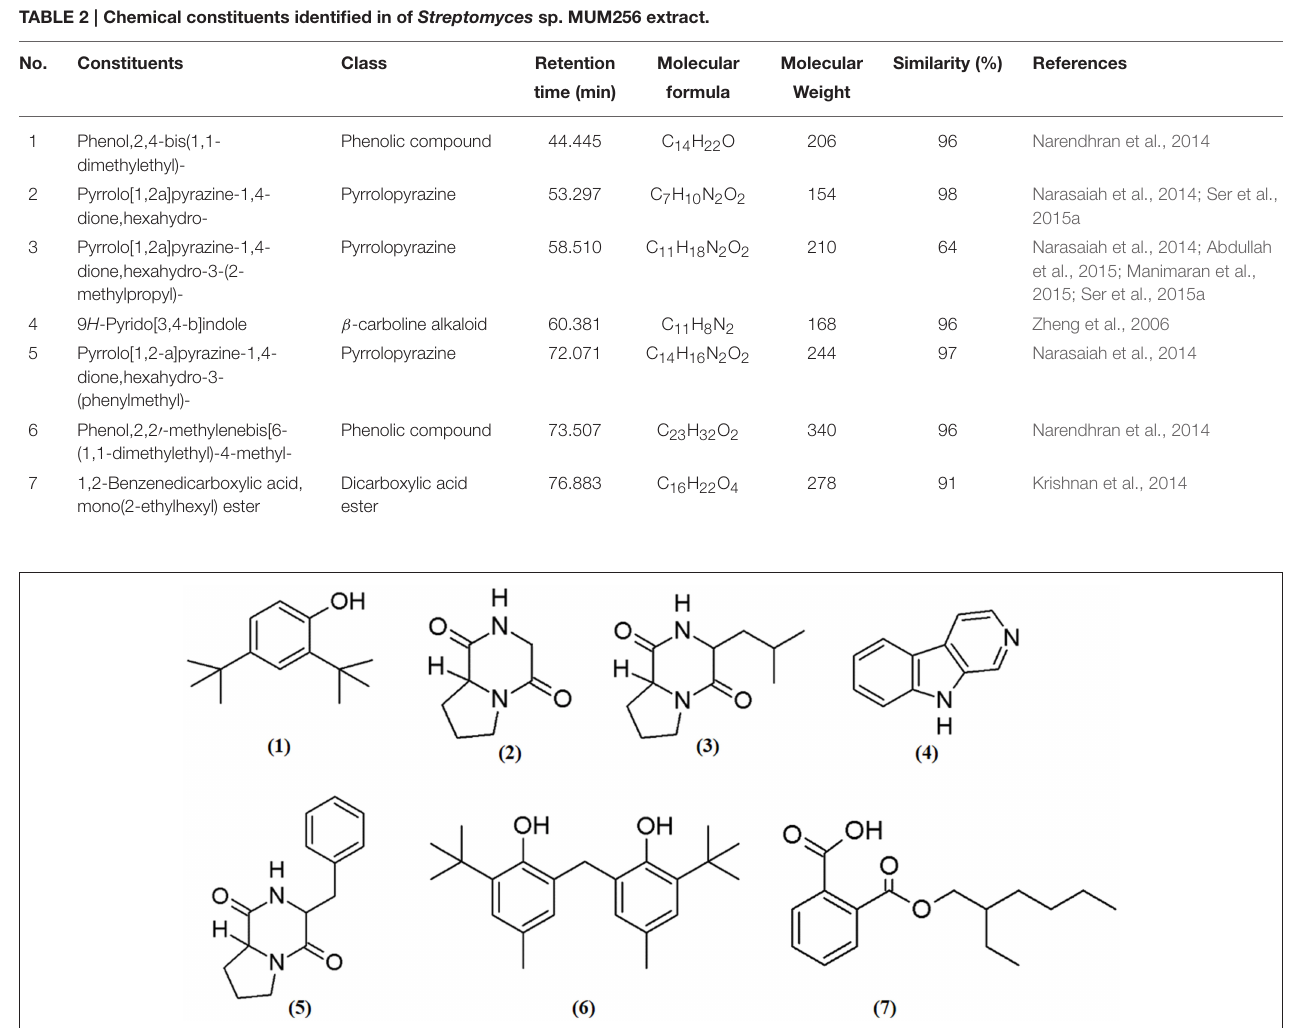
FIGURE 5 | Chemical structures of constituents detected in MUM256